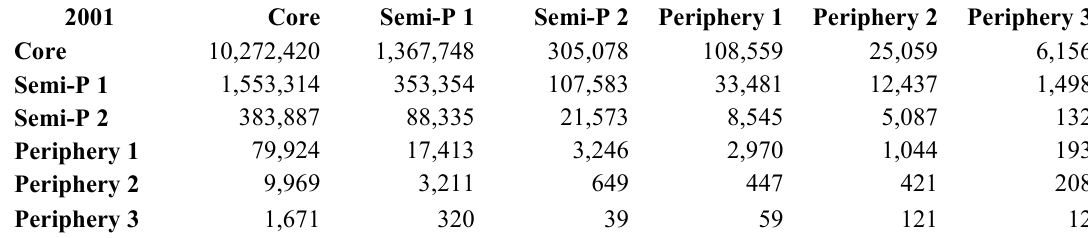
Table 4: Values Represent Average Trade Within and Between Blocks in Thousands of US Dollars 2001